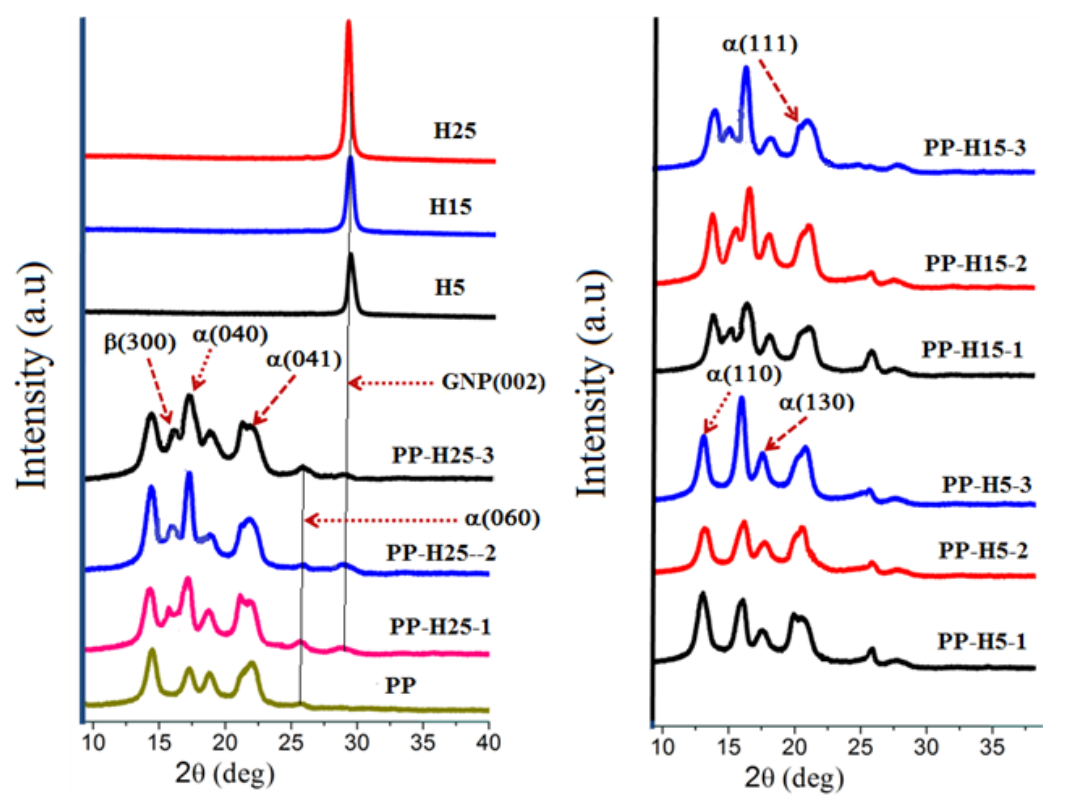
Figure 9. X-Ray diffractograms of PP, GNPs and the prepared nanocomposites. Figure 9. X-ray diffractograms of PP, GNPs and the prepared